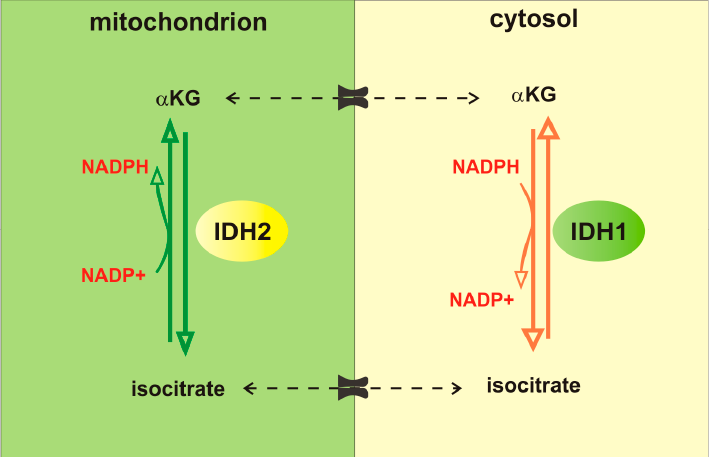
Figure 2. Isocitrate- α KG cycle modulates the NADP/NADPH balance. IDH1 is a cytosolic enzyme, IDH2 is mitochondrial enzyme. Both IDH1 and IDH2 catalyze the conversion between isocitrate and α KG, and the reverse reaction, i.e., the reductive carboxylation of α KG yielding to isocitrate. The forward reaction reduces NADP to NADPH, while the reverse reaction converts NADPH to NADP.